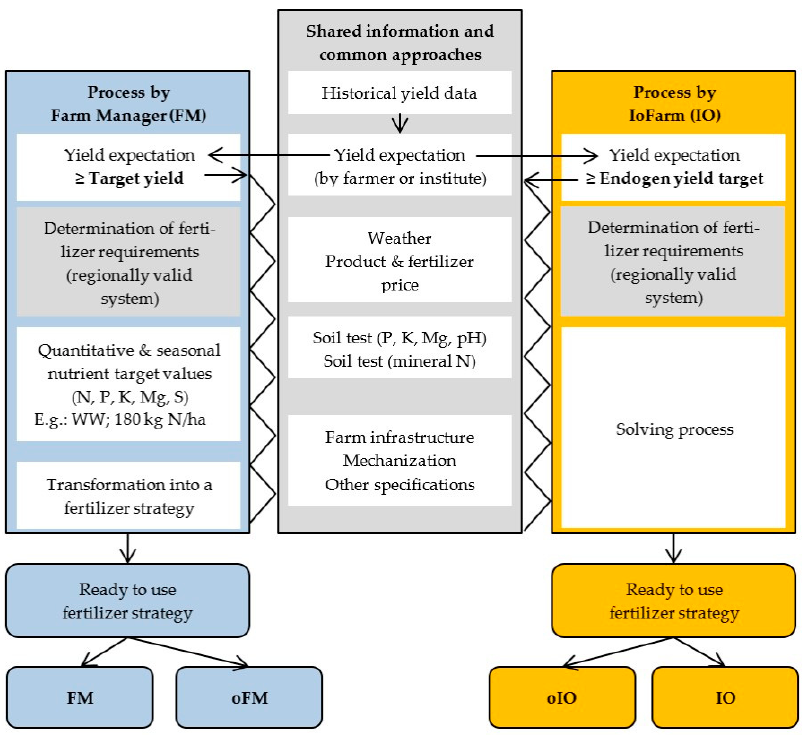
Figure 3. Similarities and differences on the way to a fertilizer strategy: Farm Manager and IoFarm.